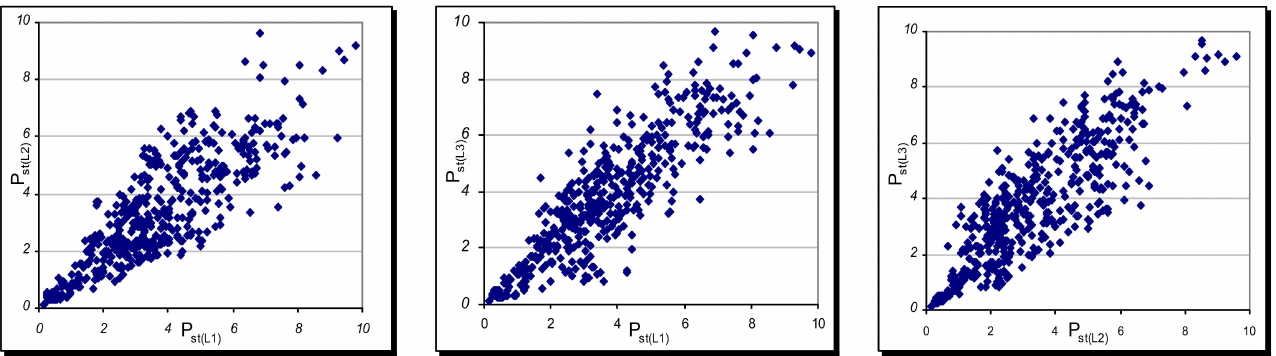
Figure 17. Relationships between the short-term flicker severity P st recorded in individual